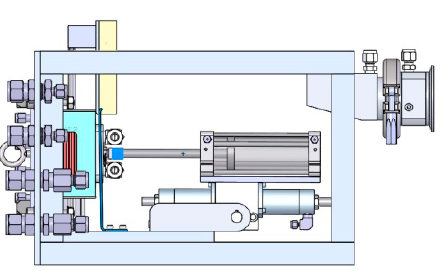
Figure 3. Ready for target placing.